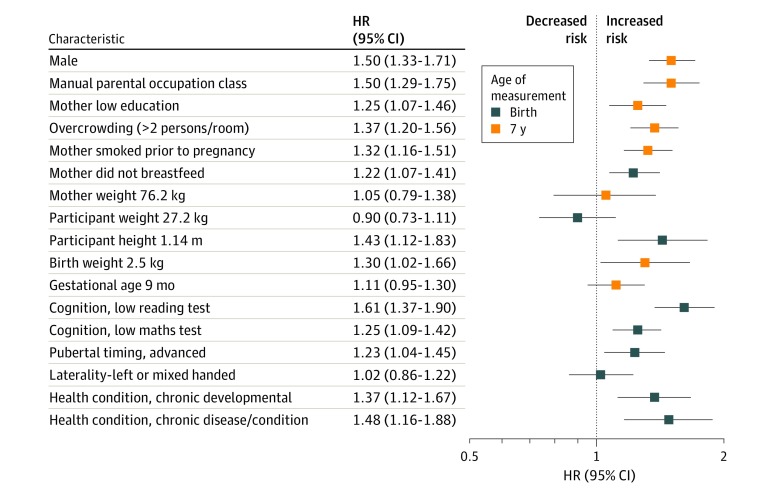
Association of Early Life Characteristics With Total Mortality Up to Age 58 YearsUnadjusted analysis shown. HR indicates hazard ratio; error bars, 95% CI.